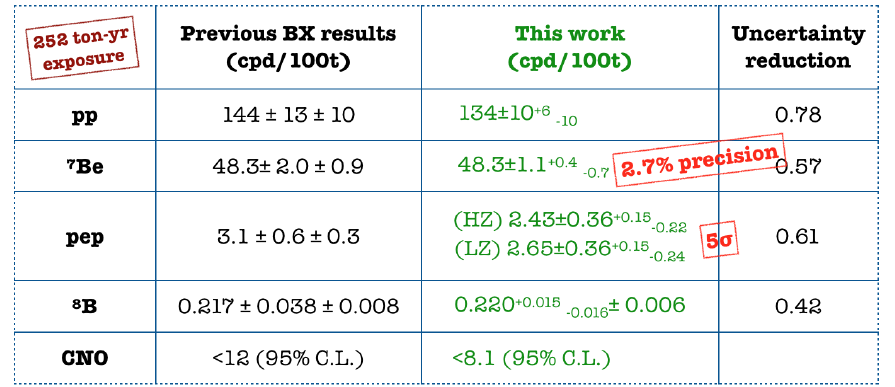
Figure 5: Phase-II Borexino solar neutrino results compared to pre-2018 measure- ments.